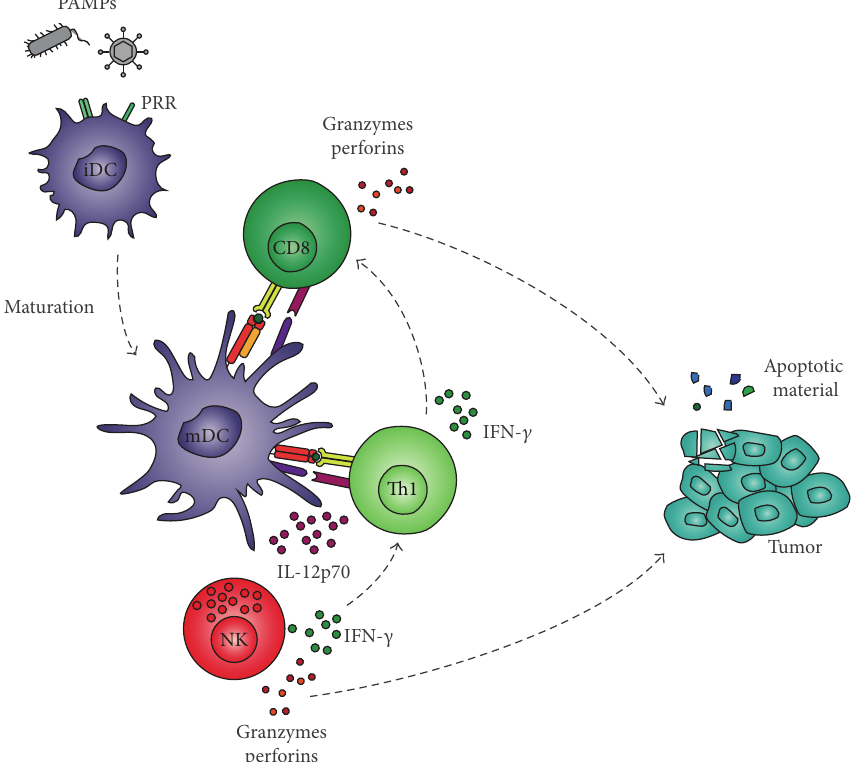
Figure 1: Desired immune interactions upon PAMP stimulation of immature dendritic cells. PAMPs trigger immature MoDC (iDC) to mature DC (mDC) and activate cells involved in antitumor responses (NK cells and CD4 + and CD8 + T cells). The (crucial) cytokine milieu (only IL-12 and IFN- 𝛾 are shown) generated by their activation can break the tolerizing effects of the TME resulting in killing of tumor cells by CD8 + T cells and NK cells. Apoptotic material from tumors may be taken up by resident DC and may enhance the immune response.